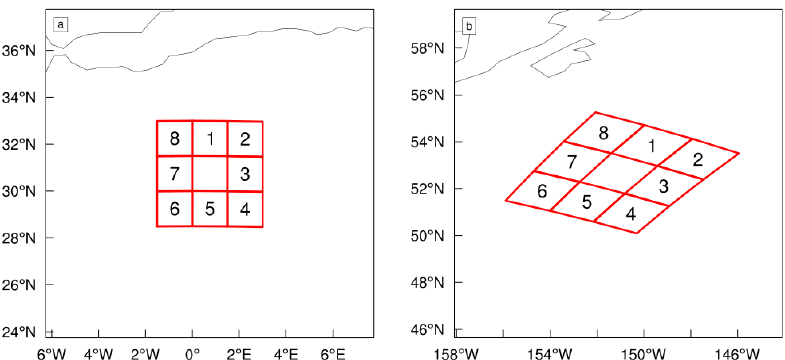
Figure 3. Examples of the nearest-neighbor detection algorithm (see text). Numbers indicate the ordering of adjacent neighbors such that the northernmost edge neighbor is first in the sequence with a clockwise order.